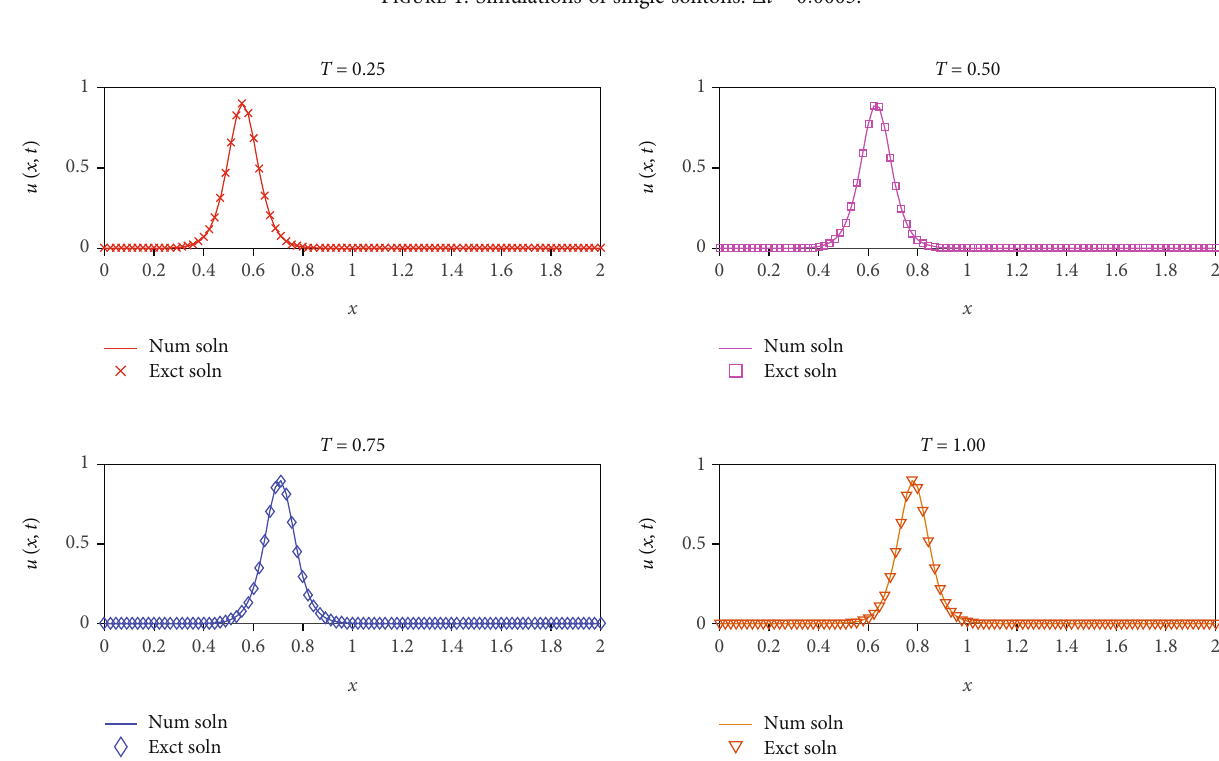
Figure 1: Simulations of single solitons: Δ t = 0 : 0005 .